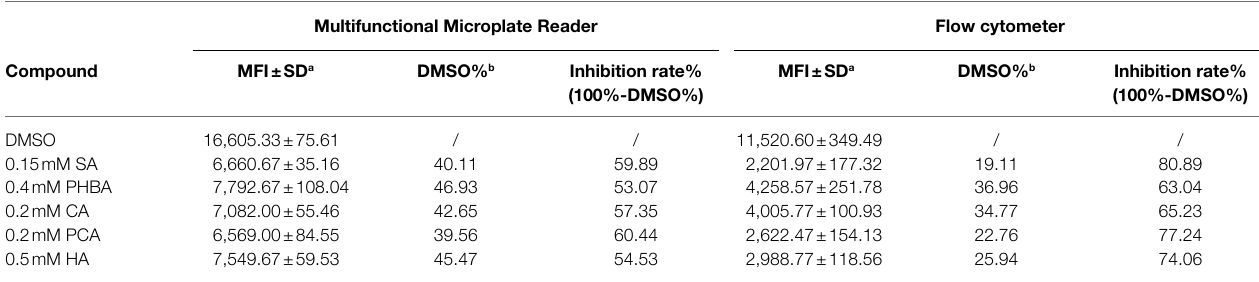
TABLE 2 | The hrpA promoter activity of MS2 in LS5 medium supplemented with optimal concentrations of compounds at 14 h of growth and the corresponding inhibition rates of the compounds toward hrpA promoter